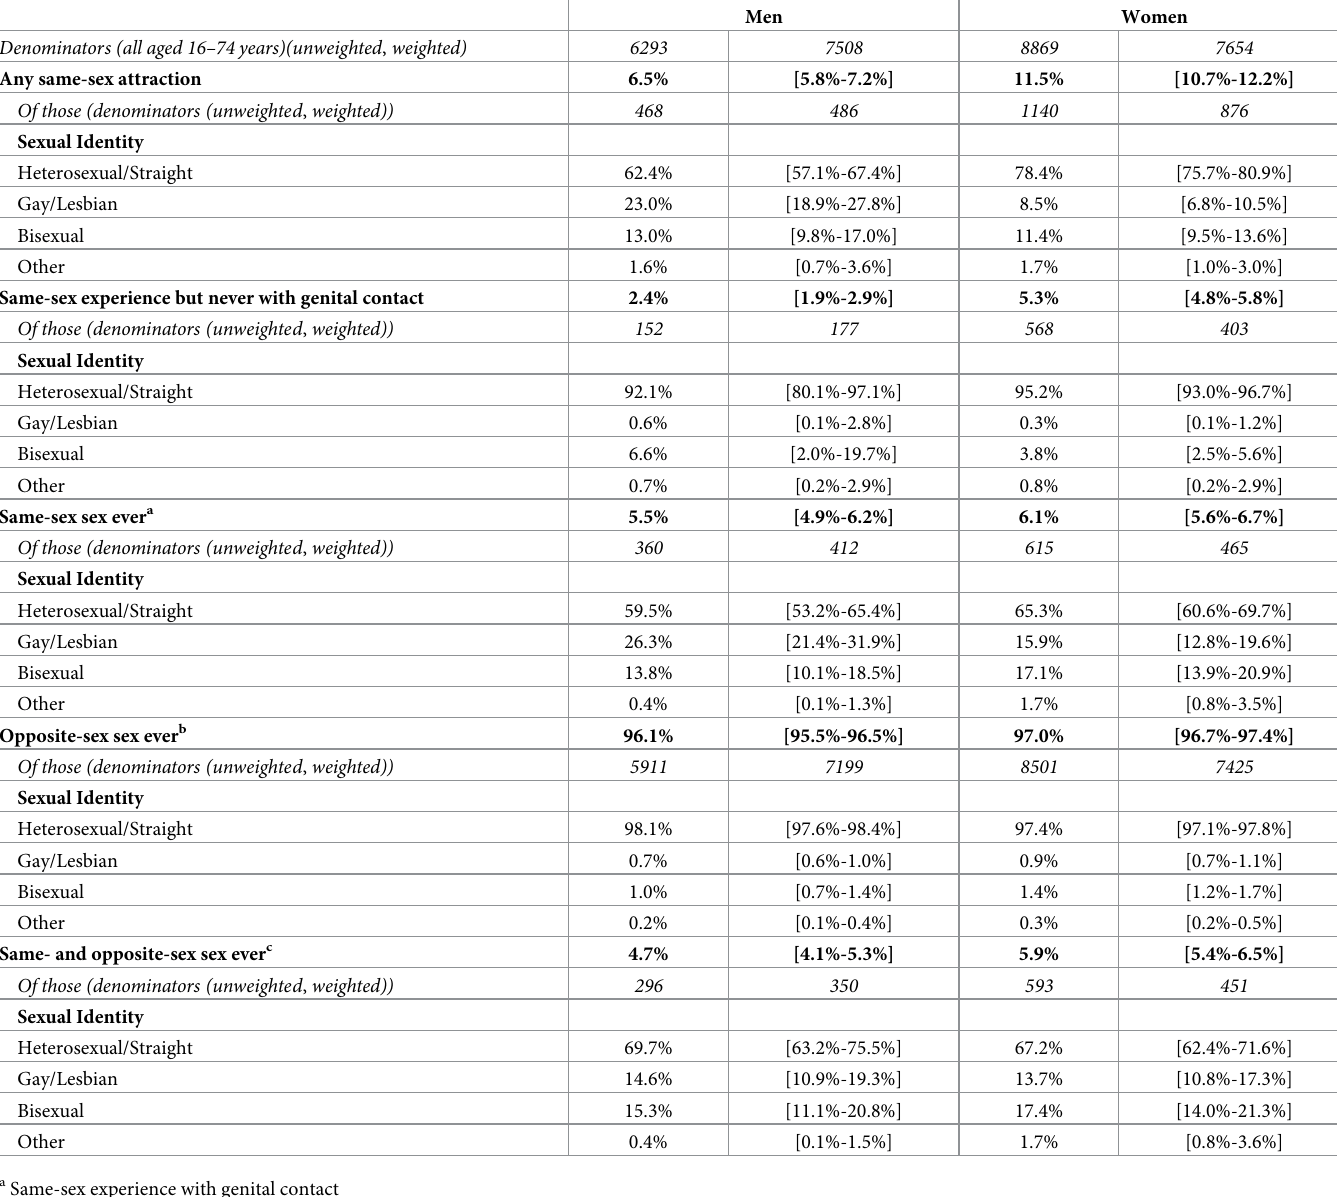
Table 2. Sexual identity by different measures of sexual attraction and behaviour among men and women aged 16–74 years.